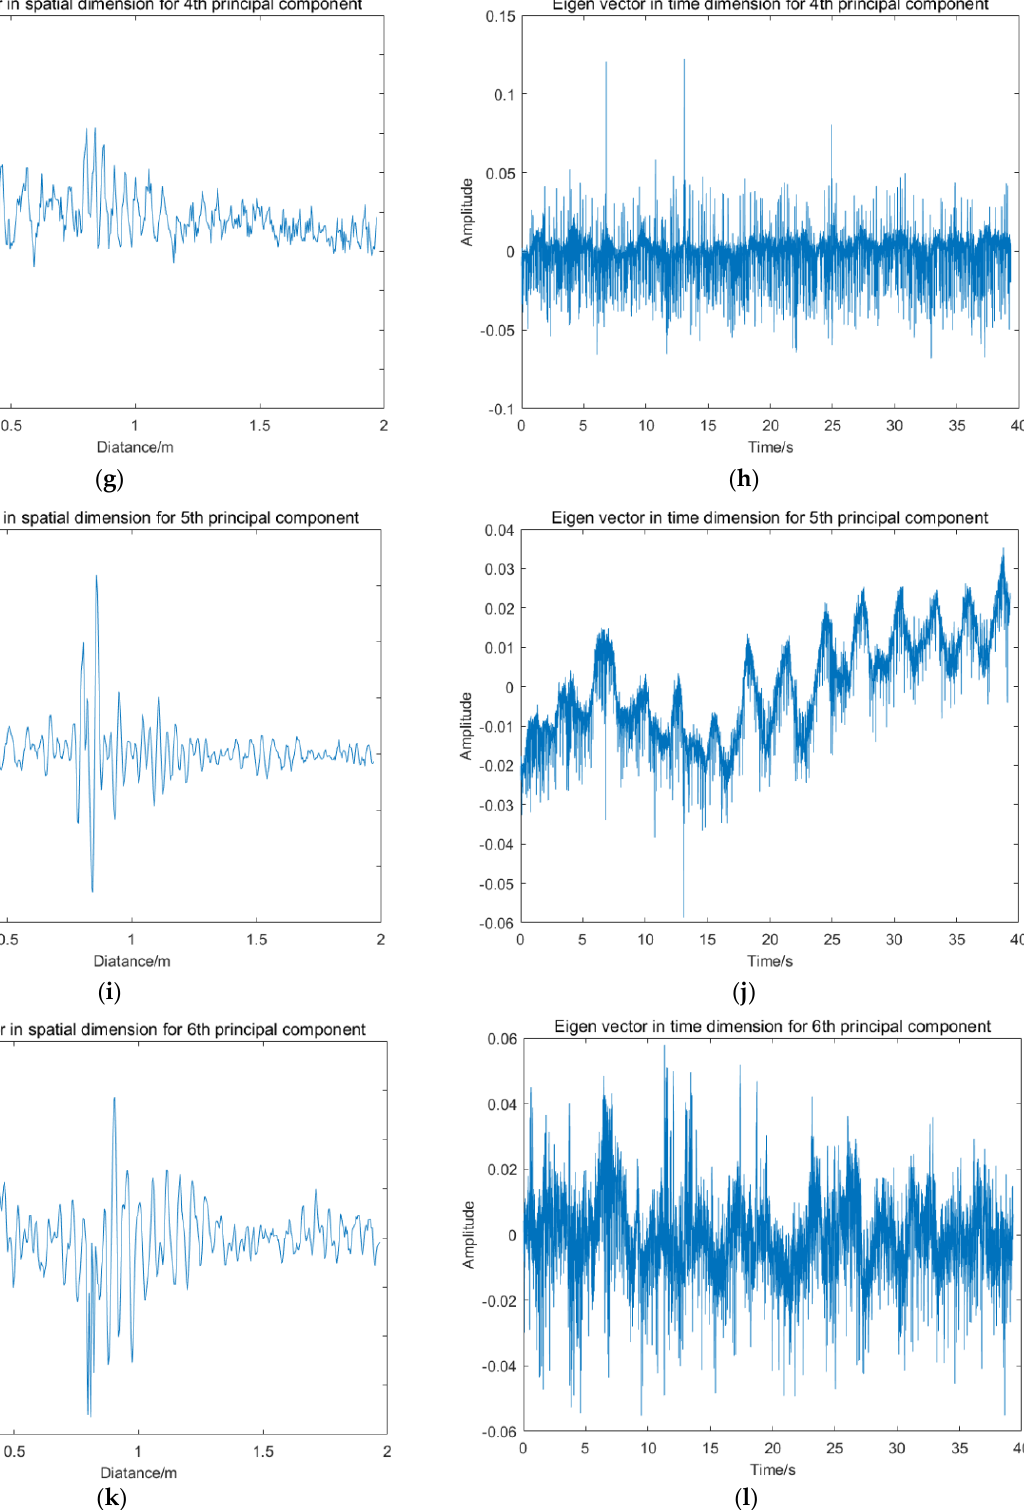
Figure 9. Temporal and spatial eigenvectors for the first six order principal components: ( a ) First spatial eigenvector; ( b ) first temporal eigenvector; ( c ) second spatial eigenvector; ( d ) second temporal eigenvector; ( e ) third spatial eigenvector; ( f ) third temporal eigenvector; ( g ) fourth spatial eigenvector; ( h ) fourth temporal eigenvector; ( i ) fifth spatial eigenvector; ( j ) fifth temporal eigenvector; ( k ) sixth spatial eigenvector; ( l ) sixth temporal eigenvector.